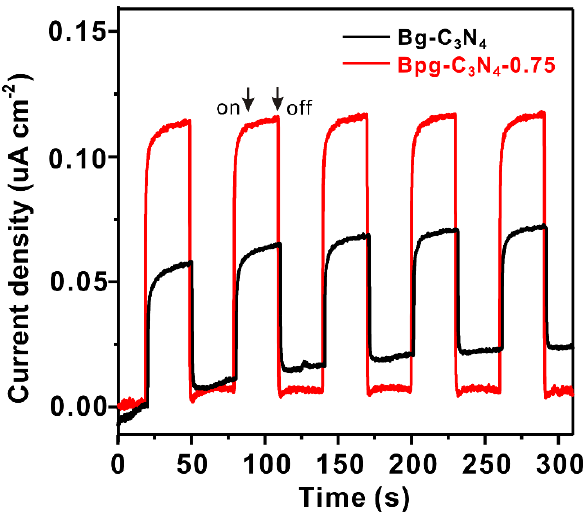
Figure 5. Photocurrent responses of Bg-C 3 N 4 and Bpg-C 3 N 4 -0.75.